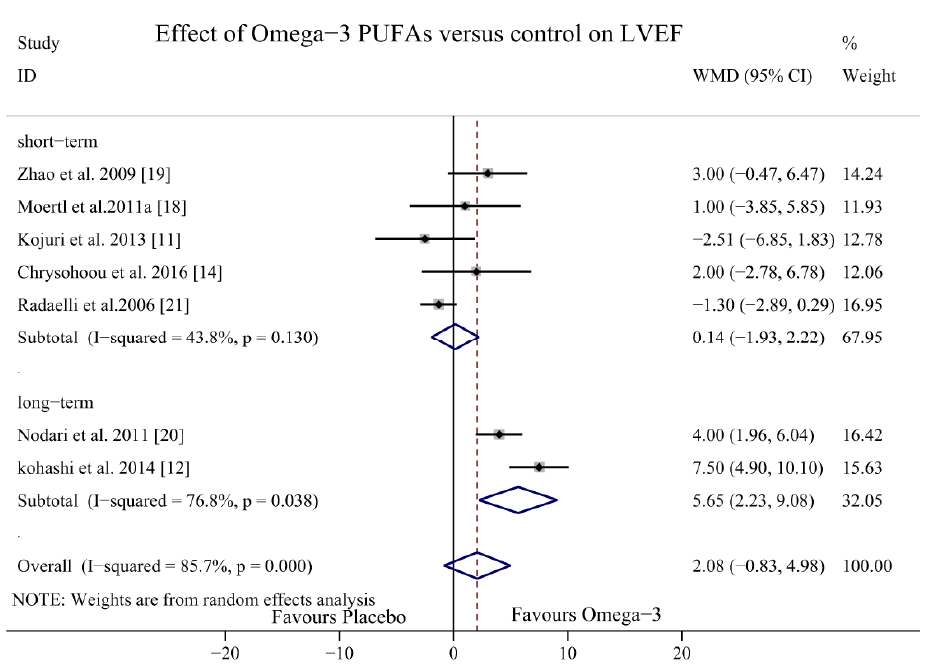
Figure 8. Forest plot depicting the time ‐ effect of omega ‐ 3 PUFAs on LVEF (WMD, weighted mean difference). Abbreviations: LVEF, left ventricular ejection fraction; PUFAs, polyunsaturated fatty acids, short ‐ term, ≤ 6 months; long ‐ term, >6 months.